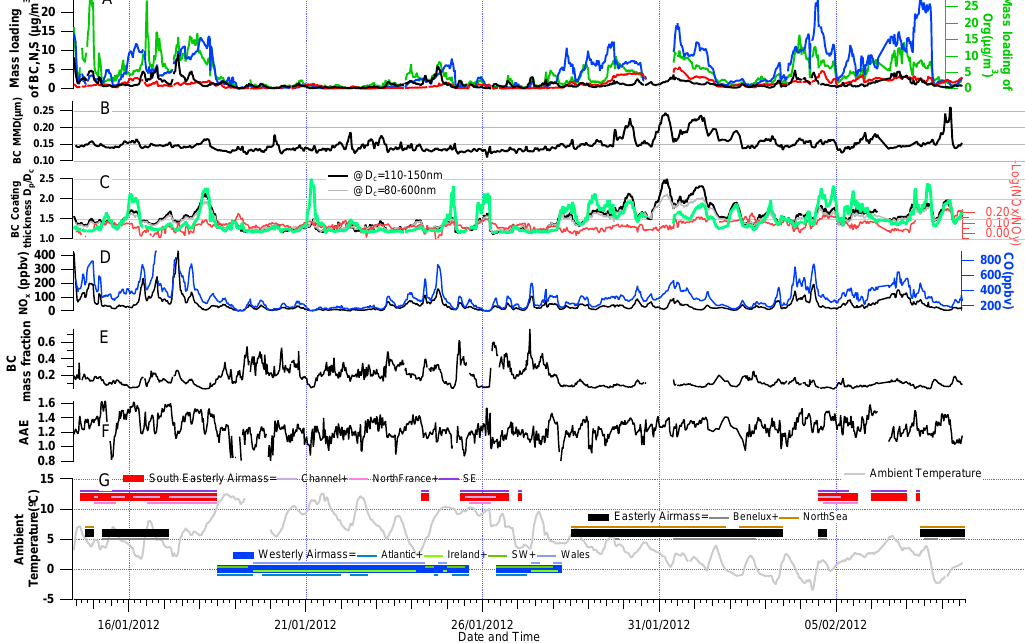
Figure 2. The aerosol/trace gas properties and air mass history for the entire experimental period. (a) rBC mass loadings from SP2, non- refractory compositions (sulfate, nitrate and total organic) from AMS; (b) mass median diameter (MMD) of BC cores ( D c ) ; (c) bulk coating thickness, D p /D c (see the definition in Sect. 2.1), within the D c range 110–150nm, and the entire SP2 detectable D c range (80–600nm), with the right red axis showing the chemical age metric − log(NO x /NO y ) ; (d) rBC mass fraction calculated as rBC mass/(rBC mass + total non-refractory mass from AMS); (e) the absorption Ångström exponent (AAE, α ) calculated from Aethalometer data (at λ ’s 470 and 950nm); (f) classified air mass category and the dominant regional air mass types derived from NAME modelling, with the grey line showing the local air